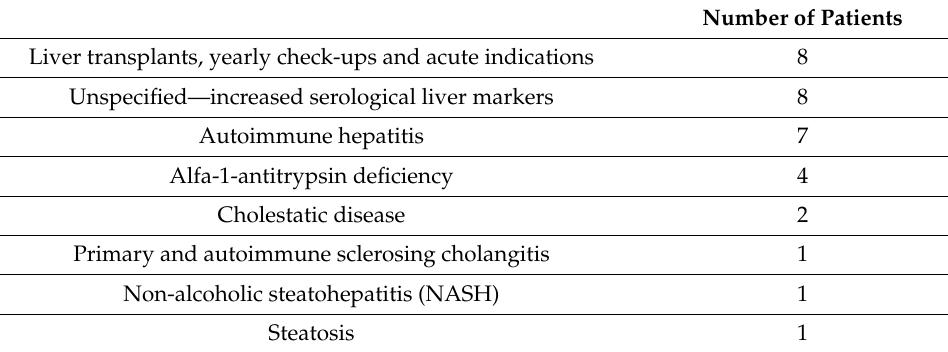
Number of Patients